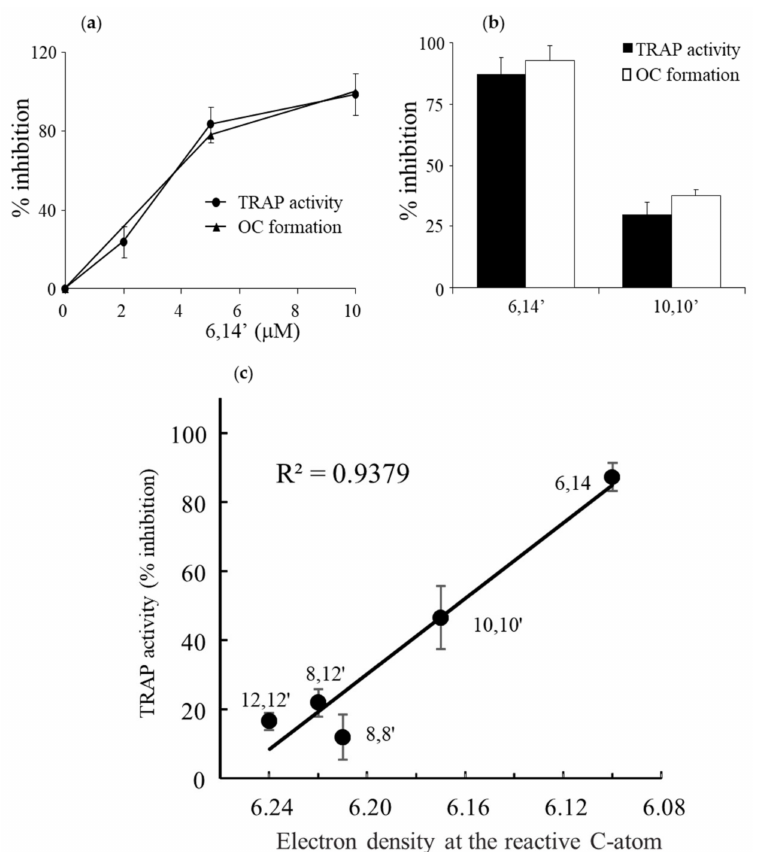
Figure 2. Diapocarotene-dials inhibit RANKL-induced osteoclastogenesis. Osteoclast di ff erentiation was measured as described in the Materials and Methods section and in Figure 1. Cell were incubated with RANKL alone or with ( a ) di ff erent concentrations of the diapocarotene-dial 6,14 (cid:48) or ( b , c ) with 10 µ M di ff erent diapocarete-dials. Inhibition is shown in relation to positive control with RANKL. ( b ) Comparison of the inhibition by 6,14 (cid:48) and 10,10 (cid:48) . Values are the means ± SE of 3–14 experiments, each performed in triplicate, p < 0.01 for the di ff erence between the % inhibition with 6,14 (cid:48) vs. 10,10 (cid:48) . ( c ) Correlation between the electron density at the reactive C-atom of the various diapocarotene-dials and the % inhibition of osteoclast TRAP activity. Values are the means ± SE of 3–11 independent experiments, each performed in triplicate. The results are statistically significant (ANOVA test) p <